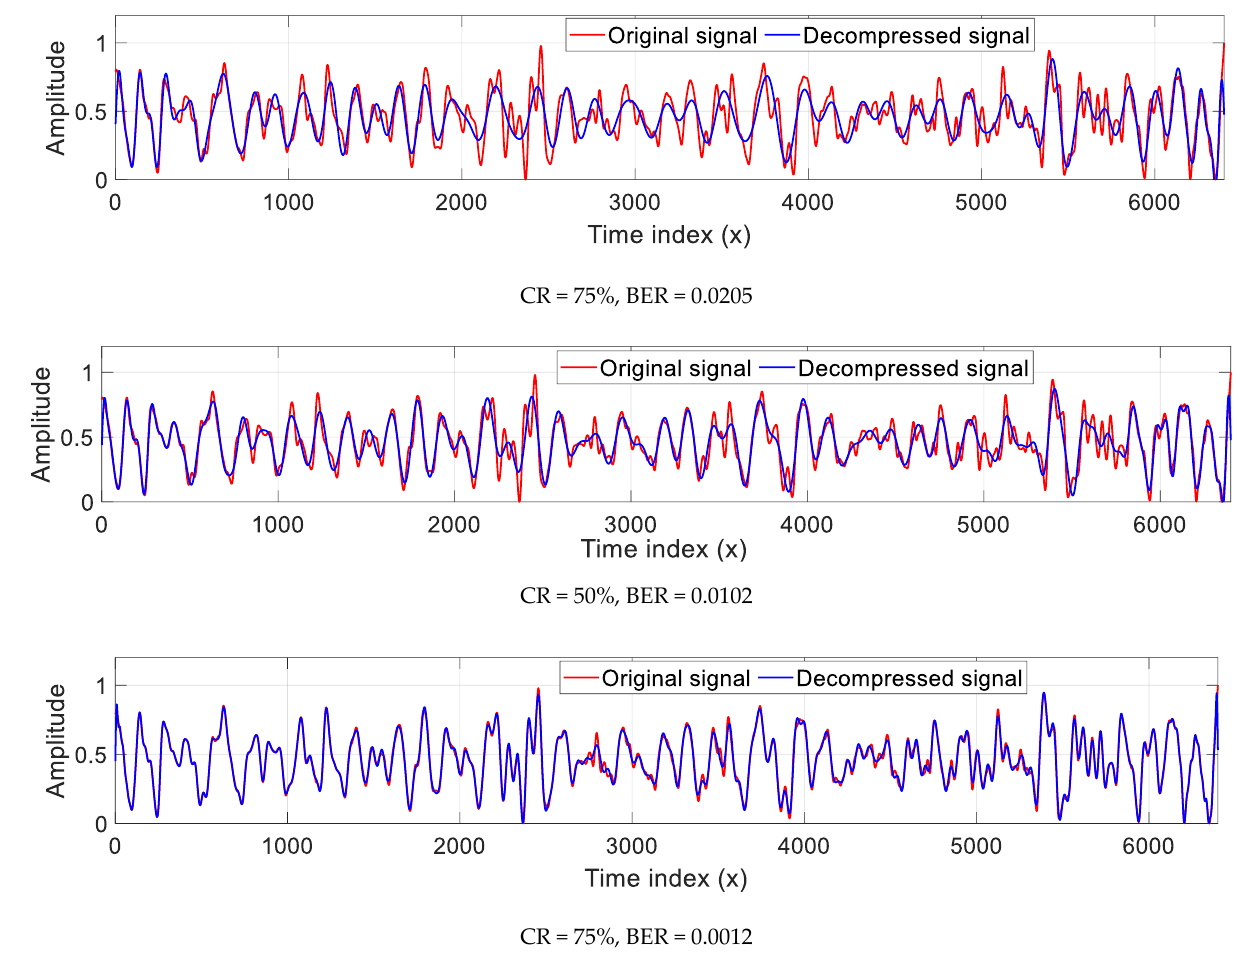
Figure 19. Original MMG signal and its compressed versions with the corresponding BER values.